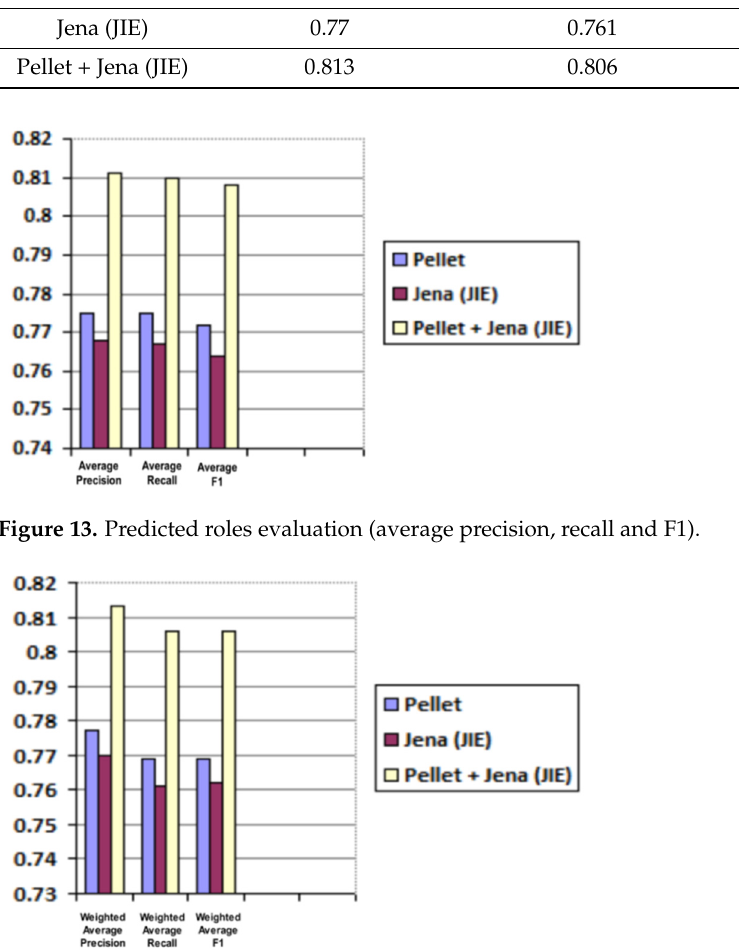
Figure 14. Predicted roles evaluation (weighted average for precision, recall and F1).